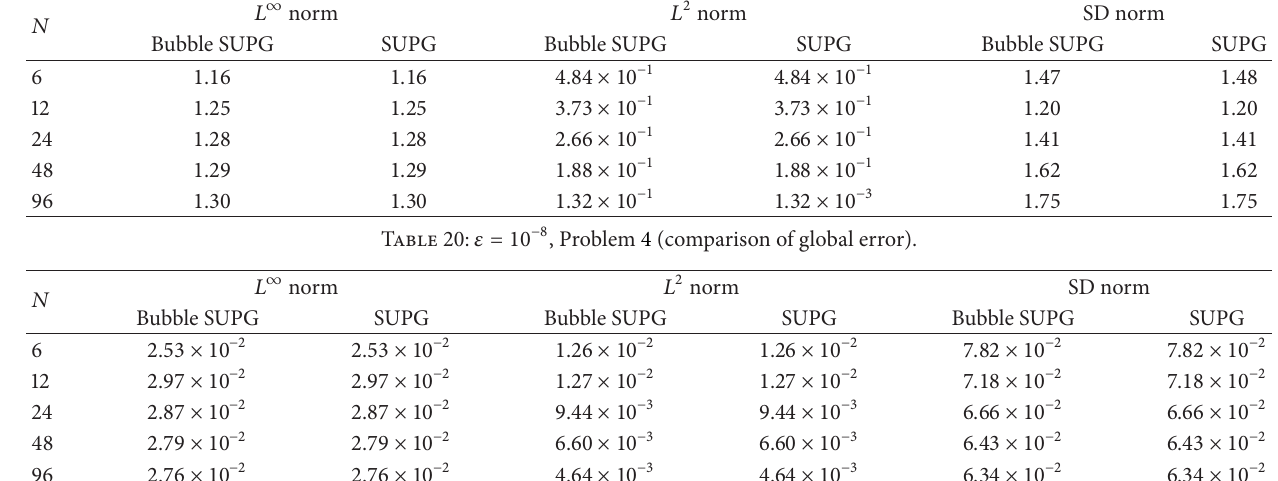
Table 19: 𝜀 = 10 −8 , Problem 3 (comparison of global error).